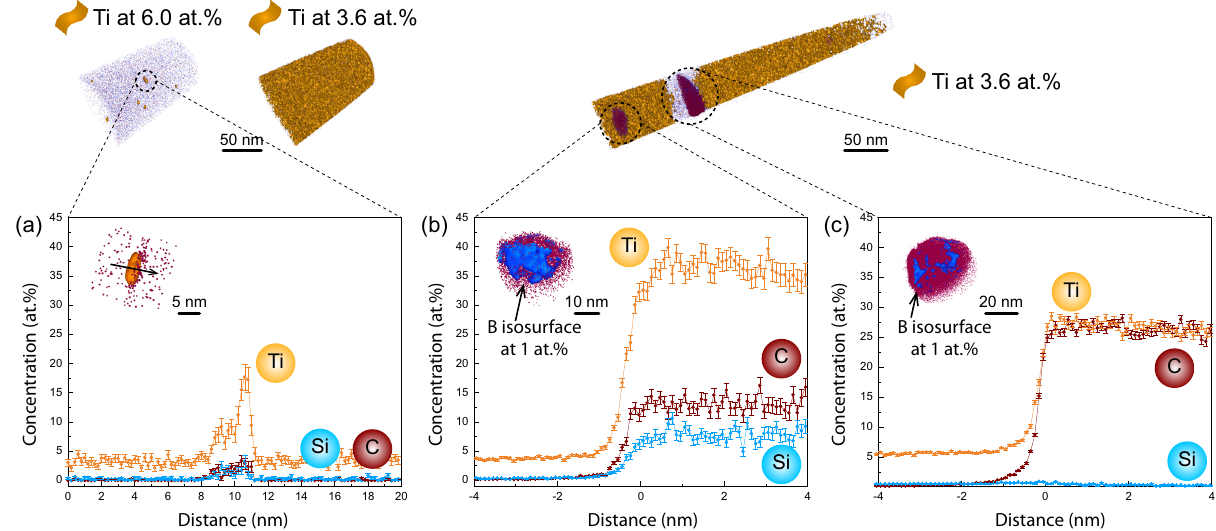
Fig.9|APTmeasurementsofthe0.11Sialloybuiltbyalowerlaserpowerinput of 110W. a Nanometer-sized Ti clusters are identi fi ed within the 110W sample ’ s dendrites. b Adifferenttypeofcarbideisalsodetectedwithinthedendritecloseto